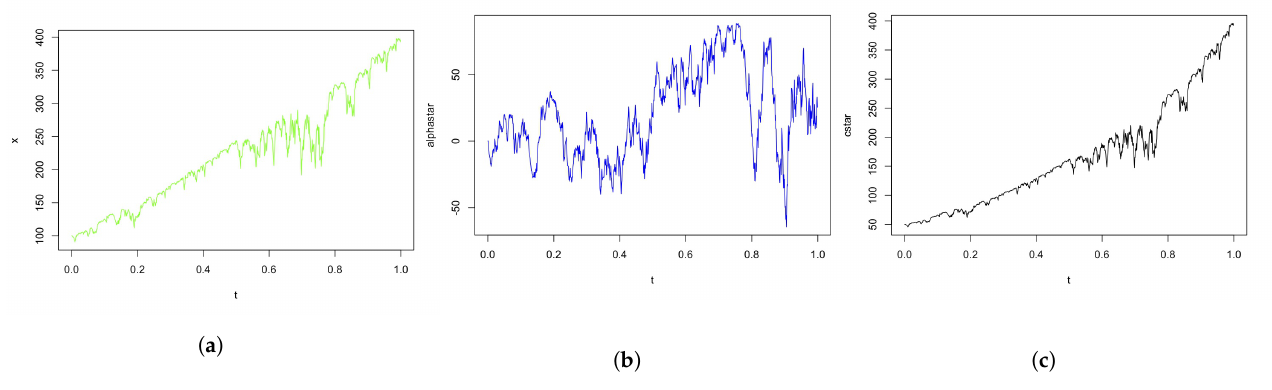
Figure 3. The wealth process with the parameters α and c when σ = 5, r = 4 and κ = 5. ( a ) The wealth process X ∗ Optimal investment α ∗